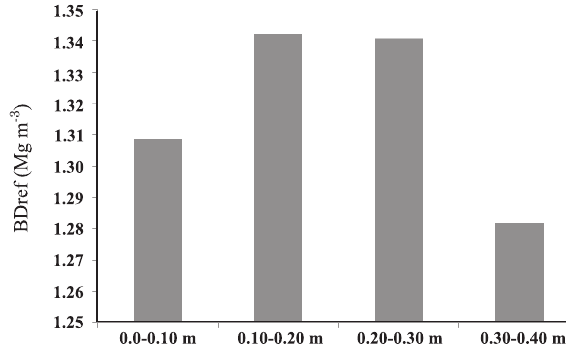
figure 1. reference soil density (Bdref) values achieved through the uniaxial compression test performed of the evaluated layers of a rhodic hapludox under nT.